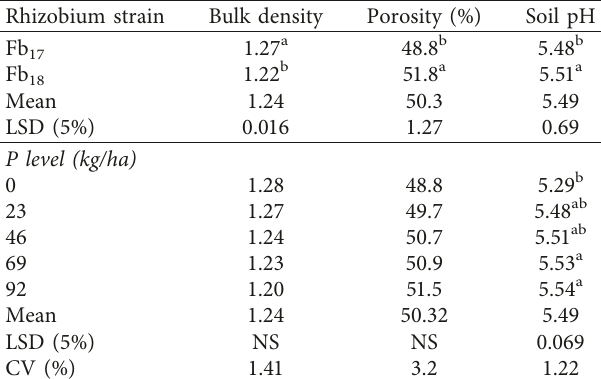
Table 2: Soil chemical properties before planting. Chemical properties